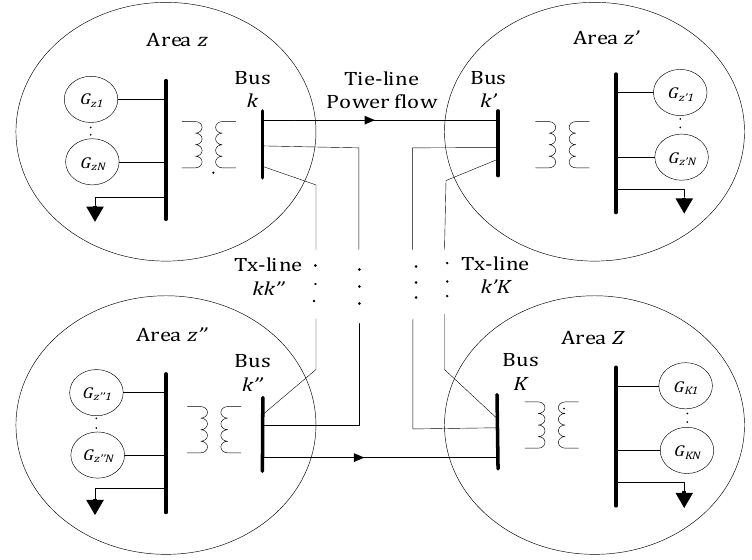
Figure 2. Schematic diagram of multiple areas interconnected power system. In Equation (3), P Act and P Sch are the actual and scheduled power from area z to z (cid:48) respectively. The variance between these two parameters is called tie-line error and is represented by ∆ P tie . β z is the frequency bias constant for area z , and is given as β z = D z + 1 Here, D z is the power system damping, R z is the governor droop and ∆ f denotes the frequency deviation from the nominal value. In a situation of contradiction between load and generation, ACE has a value other than zero and so the AGC system’s primary objective is to restore the ACE to zero in each area of the power system network. To achieve this objective, the AGC regulator, simultaneously, changes the reference point ( ∆ P ref , i ) of each generator taking part in the AGC